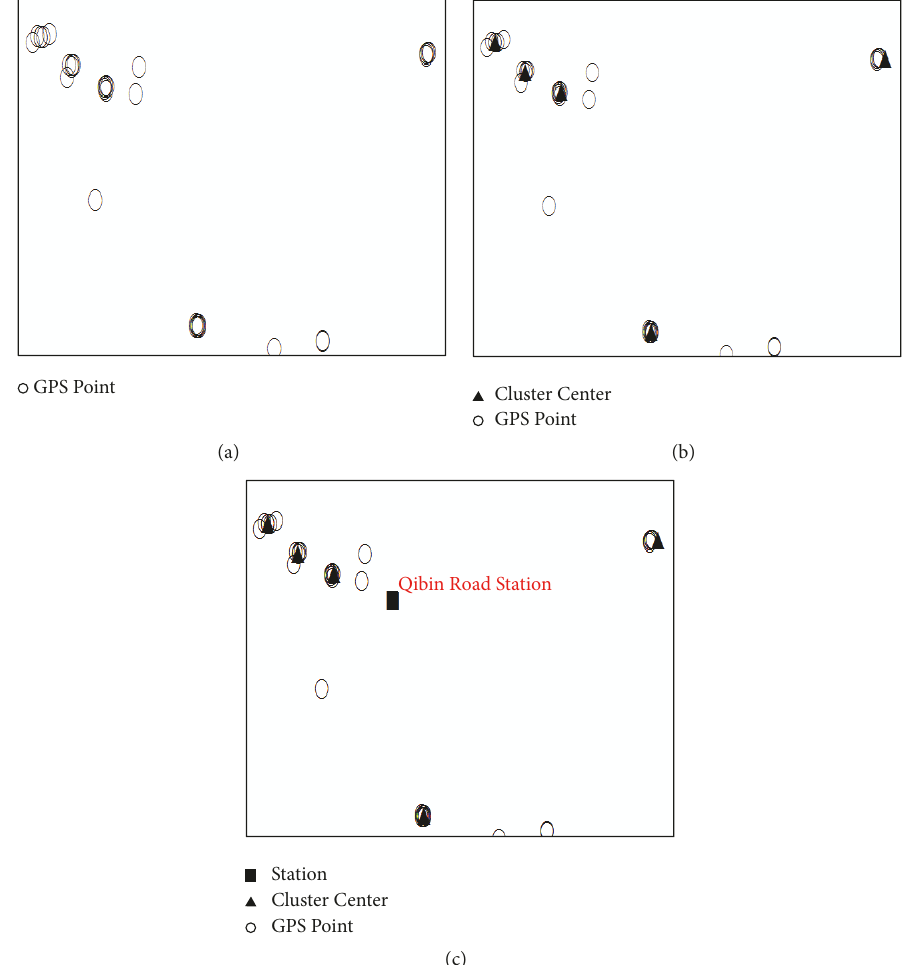
Figure 8: Coach station extraction